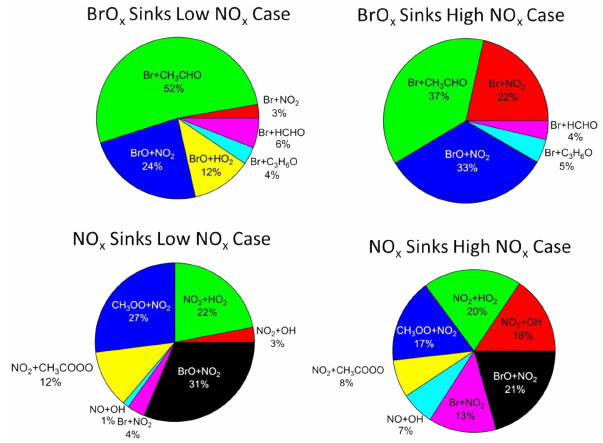
Figure 4. Fractional contributions of BrO x and NO x sink reactions from the low and high NO x simulation cases (Note that Br + NO 2 only represents BrNO 2